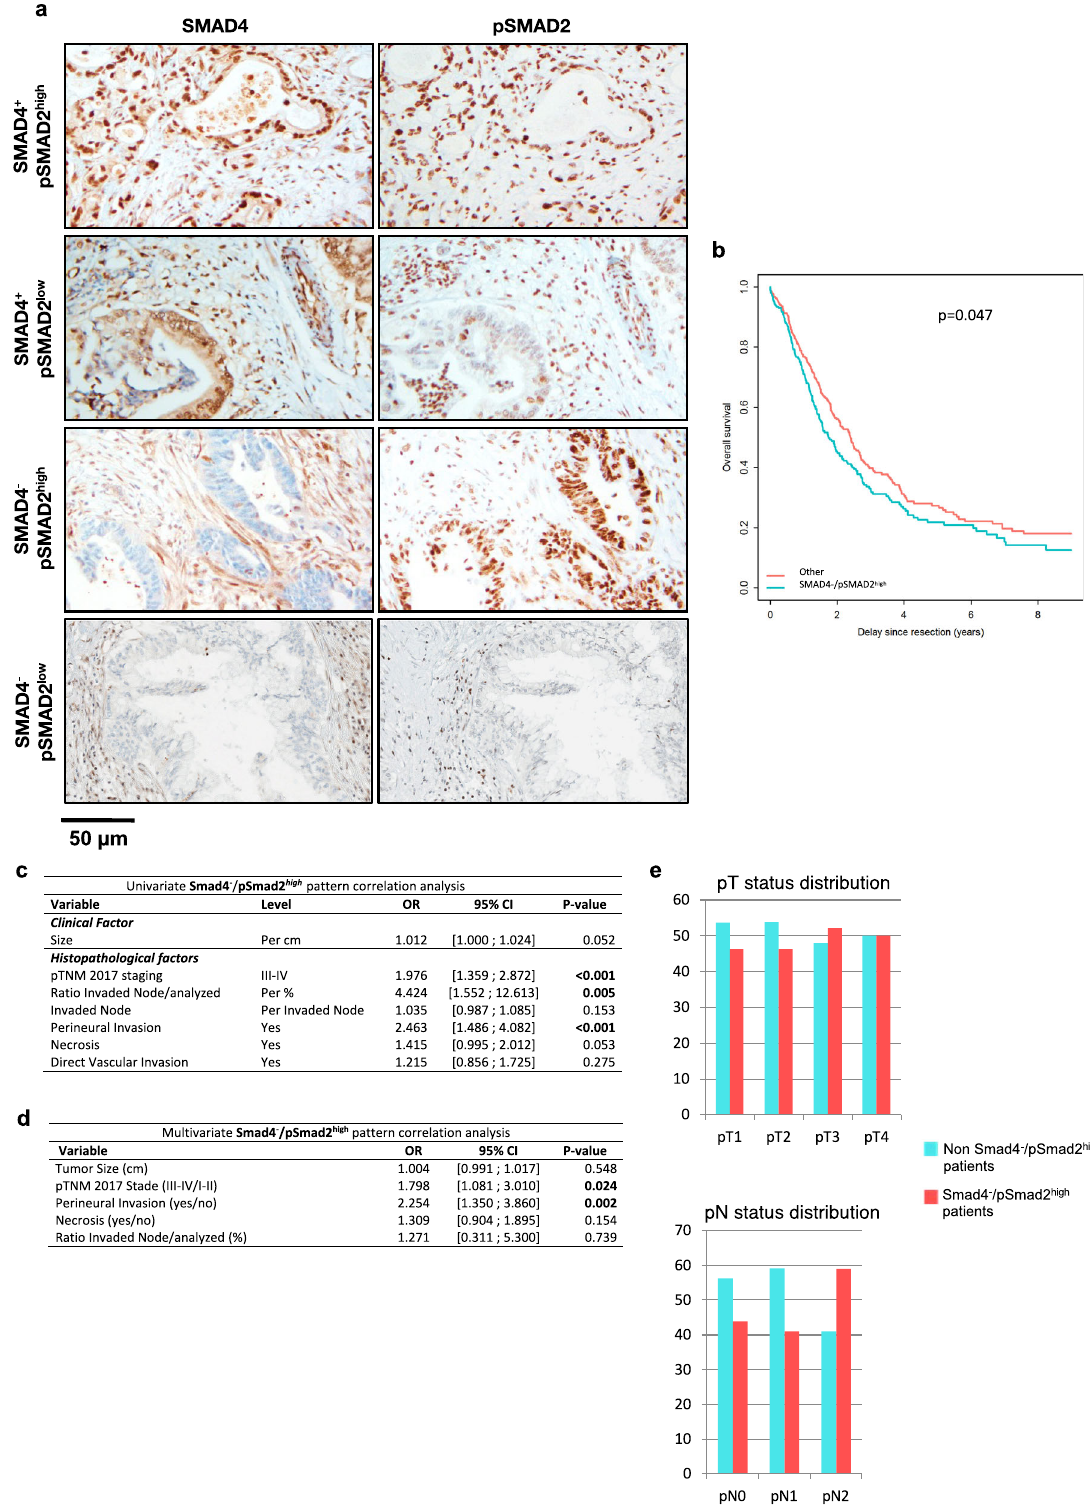
Fig. 4 pSMAD2 high /SMAD4 - pancreatic tumors are correlated with increased aggressiveness in vivo. a Immunohistochemistry for SMAD4 and pSMAD2 on 506 clinically annotated resected primary human PDAC. The tumors were separated into four groups according to SMAD4 and pSMAD2 status (SMAD4 + /pSMAD2 high , SMAD4 + /pSMAD2 low , SMAD4 - /pSMAD2 high , SMAD4 - /pSMAD2 low ). b Survival curve of patients with SMAD4 - /pSMAD2 high PDAC compared to pooled three other groups. c Univariate analysis of the correlation between the SMAD4 - /pSMAD2 high tumor pattern and aggressiveness/histopathological features. d Multivariate SMAD4 - /pSMAD2 high pattern correlation analysis. e pT and pN status distribution for SMAD4 - /pSMAD2 high tumors and non-SMAD4 - /pSMAD2 high tumors.